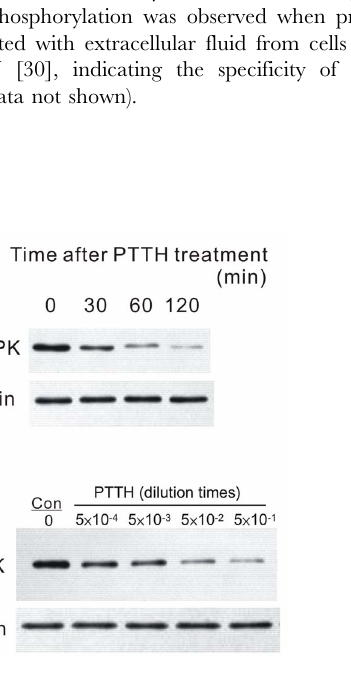
after 30 min, and the inhibition persisted for 120 min (Fig. 4A).